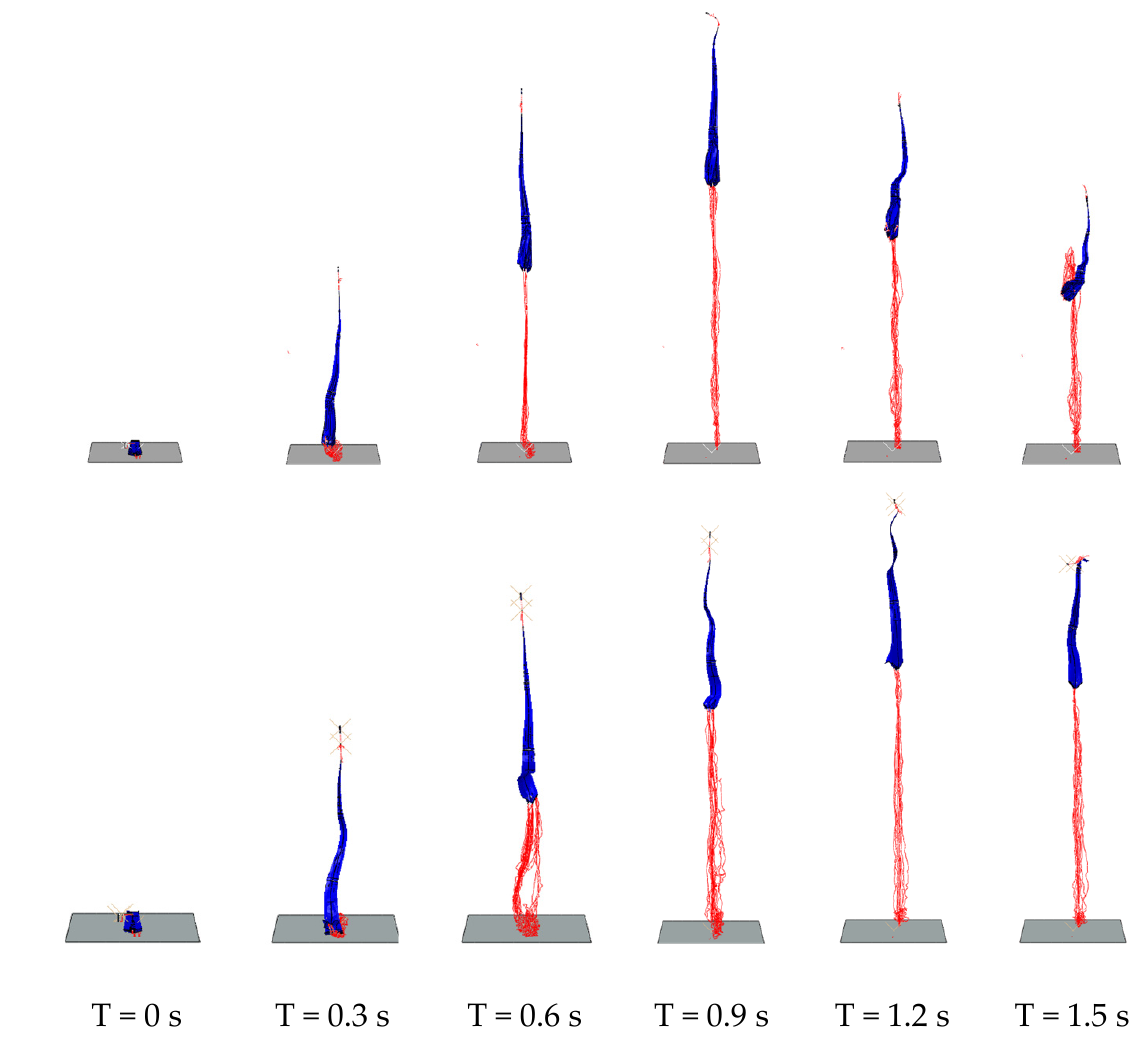
Figure 17. Different parachute weight deployment process.